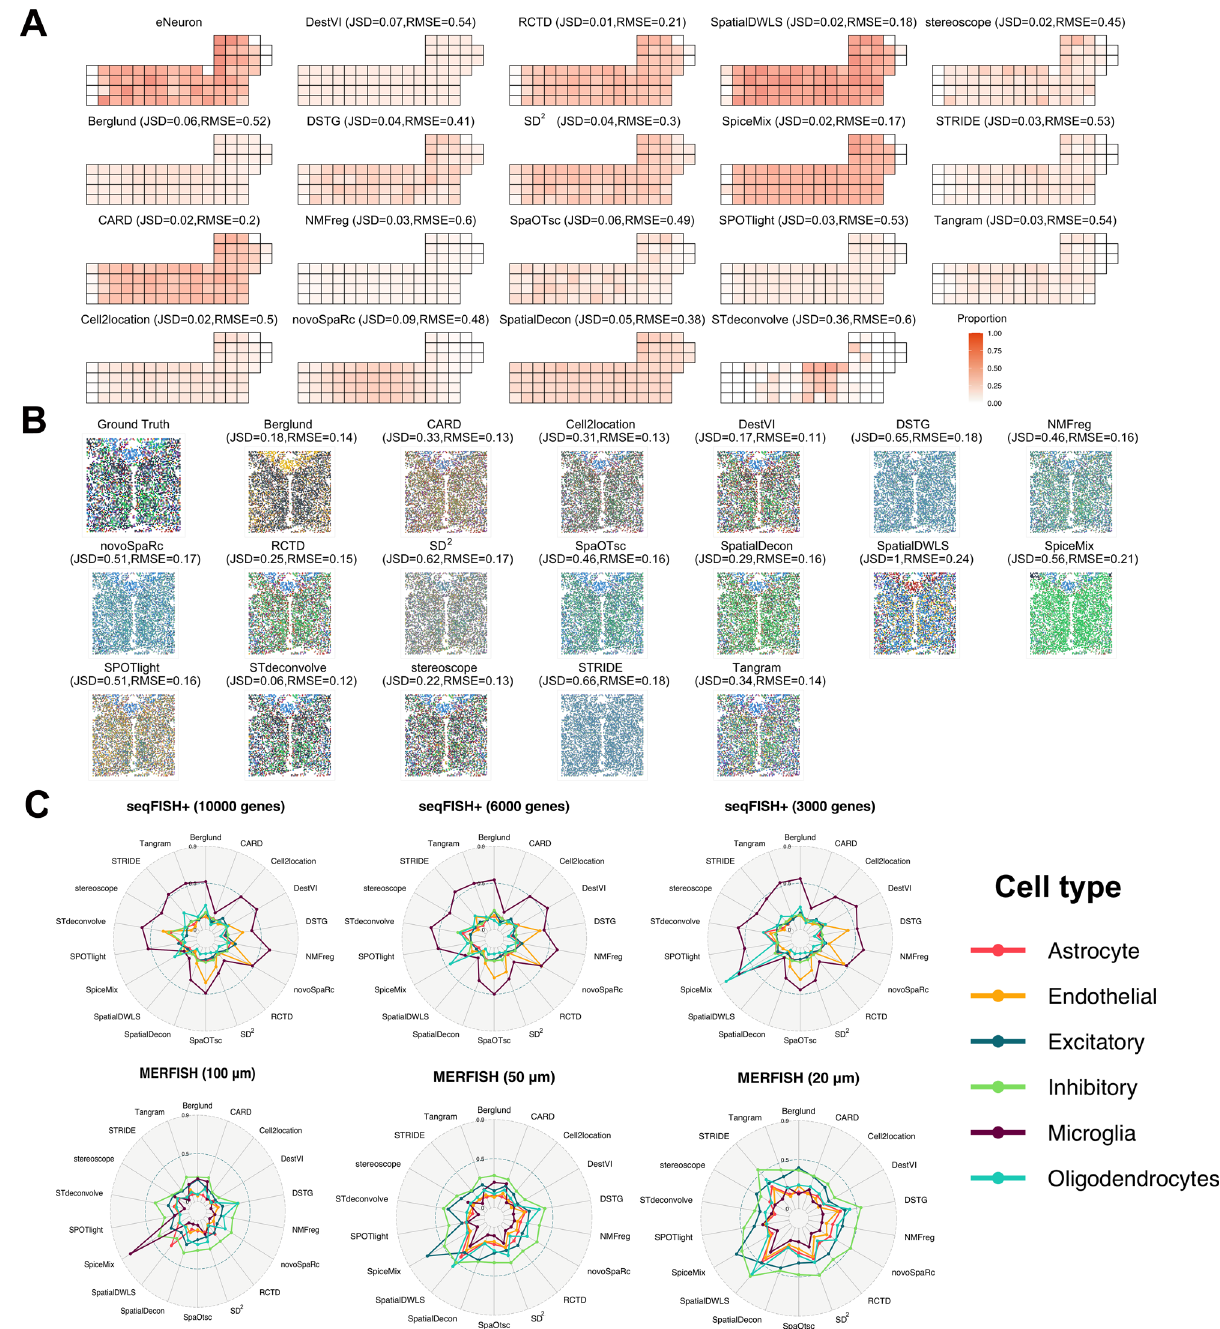
Fig. 3 | The performance of all methods for simulated datasets. A Visualization of the ground truth and predicted the proportions of excitatory neurons for 18 methods with the seqFISH+ datasets and 10,000 genes per spot. B Visualization of the ground truth and predicted results of deconvolution for all methods with MERFISH datasets (100 μ m resolution per spot). The six cell types are represented